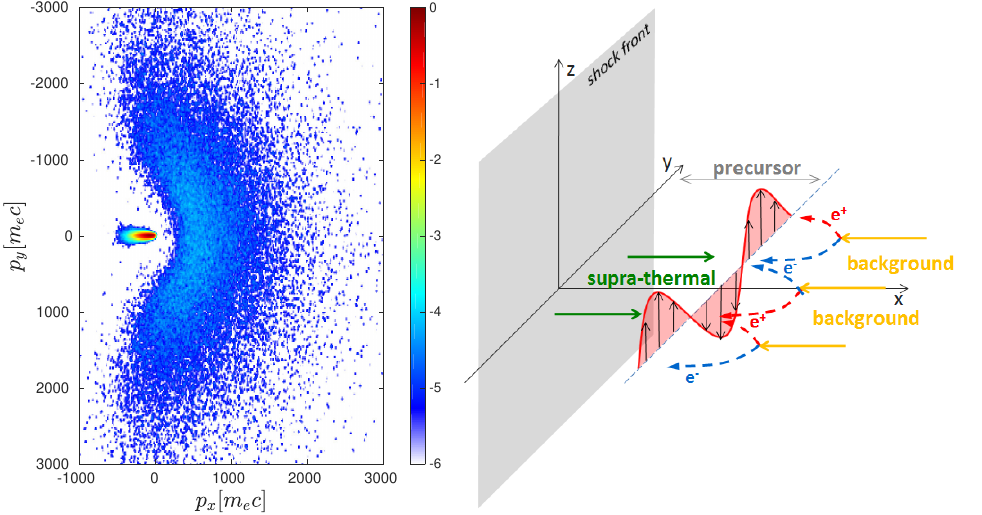
Figure 2. Left panel: Density distribution (in log scale, as indicated by the color code) in momentum 10 phase space, in the precursor of an unmagnetized relativistic shock with γ sh = 173 (i.e., γ u | d = 100), as measured in the downstream rest frame of a particle-in-cell (PIC) simulation, close to the shock front. The background plasma corresponds to the compact red (dense and cold) population, moving towards − x . The suprathermal particle population, by contrast, appears as a relativistically hot and dilute cloud. Right panel: Mechanism of the current filamentation instability (CFI) induced by the mixing of the background and suprathermal plasmas. The pink harmonic perturbation represents a magnetic perturbation δ B z and the dashed lines indicate how the charged species are deflected, thus building up current filaments that amplify the magnetic perturbation. Adapted from